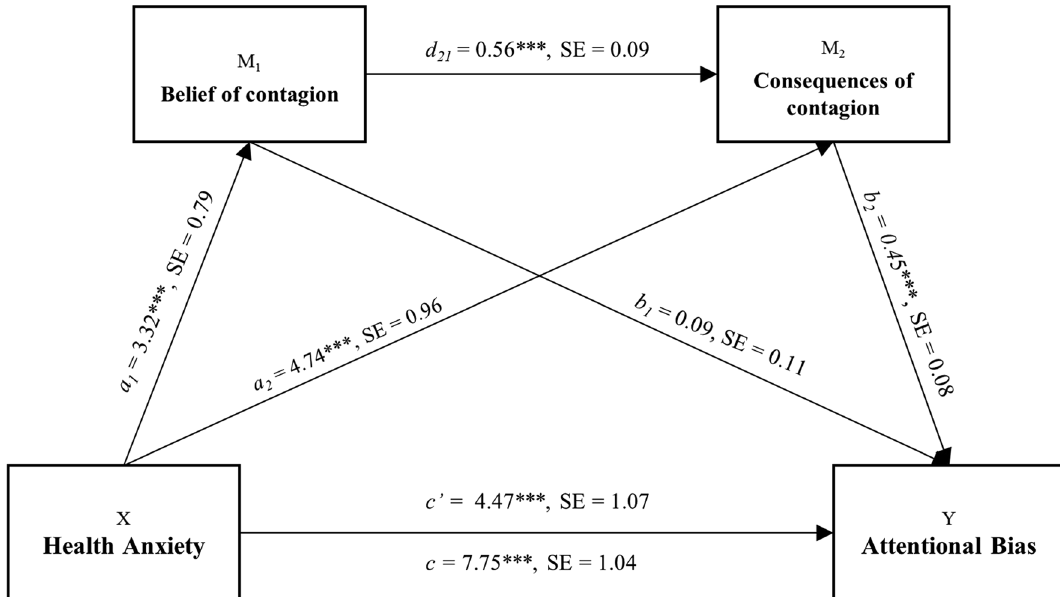
Figure 1. Serial mediation model. ***p < .001, SE standard error.